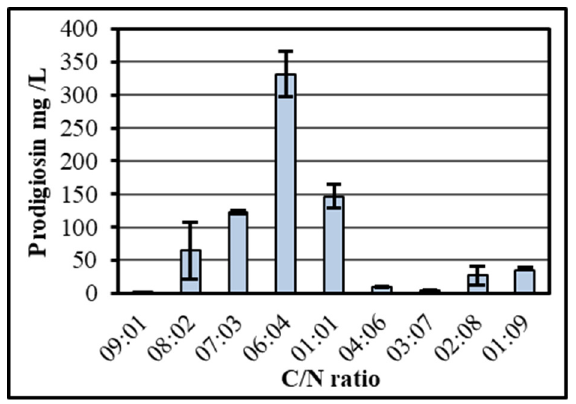
Fig. 3. The effect of carbon to nitrogen ratio on prodigiosin production by S. in chemically defined liquid medium.